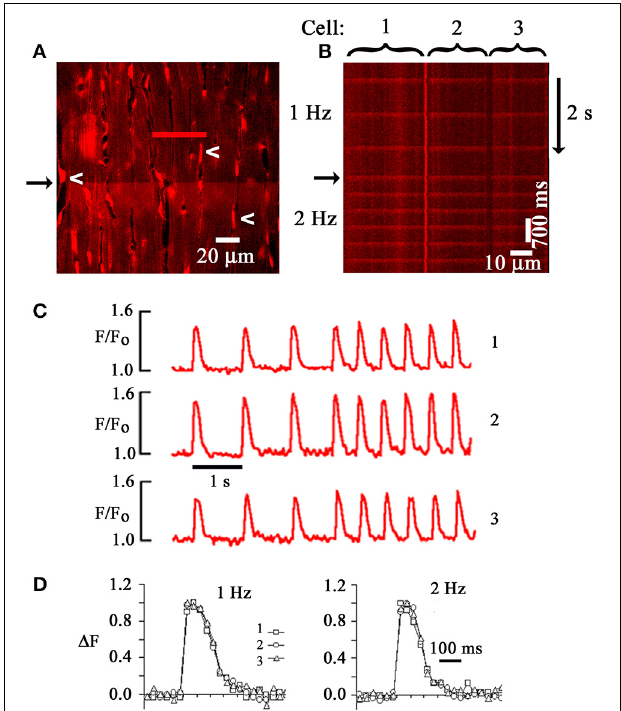
FIGURE 1 | Two-photon laser scanning microscopy-based imaging of action potential-evoked [Ca 2 + ] i transients in the Langendorff-perfused mouse heart. (A) Frame-mode image of a rhod-2 loaded heart obtained from the left ventricular epicardium during two-photon excitation (810nm). Emission was measured in the 560–650nm range. White arrows point to endothelial cell nuclei. Cytochalasin D (50 μ mol/L) was used to uncouple contraction from excitation. An electrical stimulus delivered at a point remote from the imaged area caused a simultaneous increase in rhod-2 fluorescence, i.e., [Ca 2 + ] i , along the horizontal scan line (black arrow). (B) Line-scan image obtained by repeatedly scanning along the red line in (A) and stacking consecutive line scans vertically. The scan line traversed three neighboring cardiomyocytes. Periodic increases in rhod-2 fluorescence intensity correspond to [Ca 2 + ] i transients evoked by propagating action potentials. Black arrow marks increase in pacing rate from 1 to 2Hz. (C) time courses of spatially averaged rhod-2 fluorescence intensities (F) normalized to pre-stimulus F (F o ) for each of the three juxtaposed cardiomyocytes in (B) . (D) Superimposed tracings of the changes in [Ca 2 + ] i as a function of time for the three cardiomyocytes in (B) . Normalized changes in F ( (cid:2) F) were obtained by dividing (F-F 0 ) at each data point by the maximal (F-F o ). With permission from the American Physiological